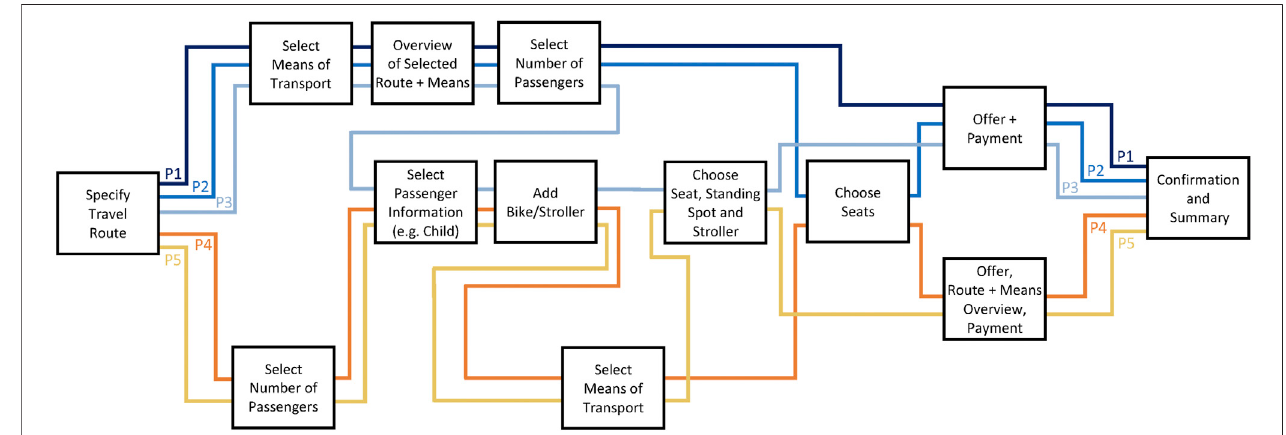
FIGURE 5 | Study 2: Overview of UI similarities and differences between prototypes